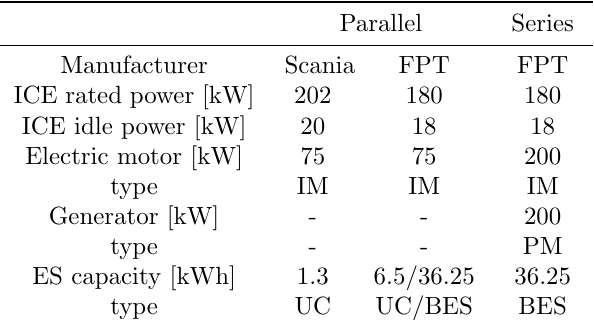
Table 4: Simulation results of the excavator